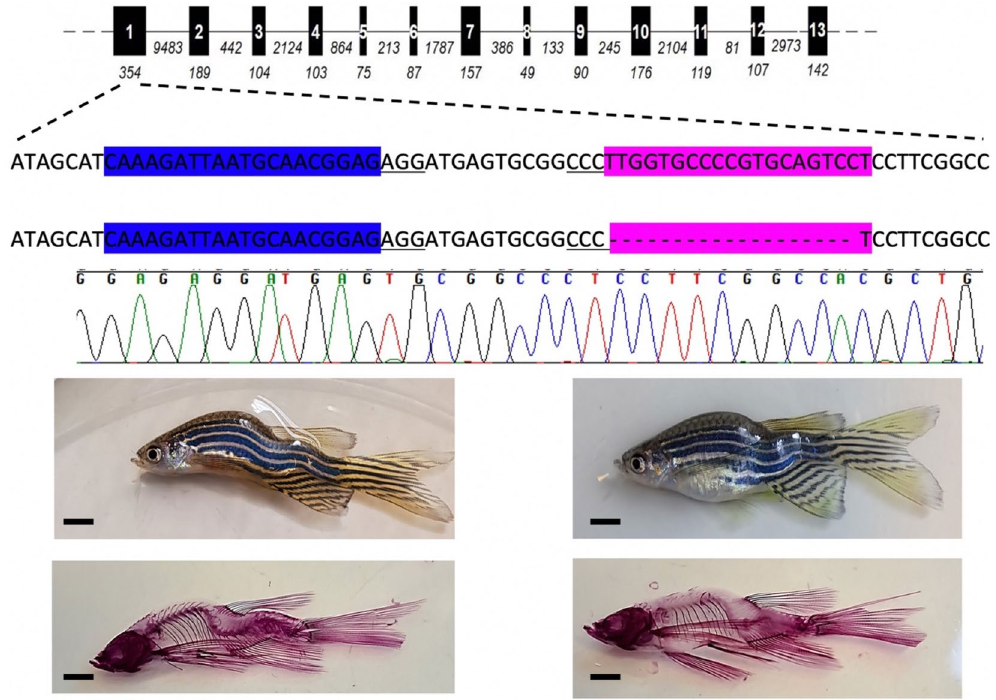
Figure 7. Scoliosis replicated in a mutant line encoding the mutation p.L82fsX24. Schematic of ppp2r3b showing the genic location of two sgRNAs used to target exon 1, highlighted in blue and pink, respectively. Deletion of 19 bp is indicated by ‘-’ symbols and the confirmatory sequence chromatogram is shown. Representative examples of two 3 month old zebrafish (above) stained for Alizarin red (below). All animals are generation F4. Scale bars are 5